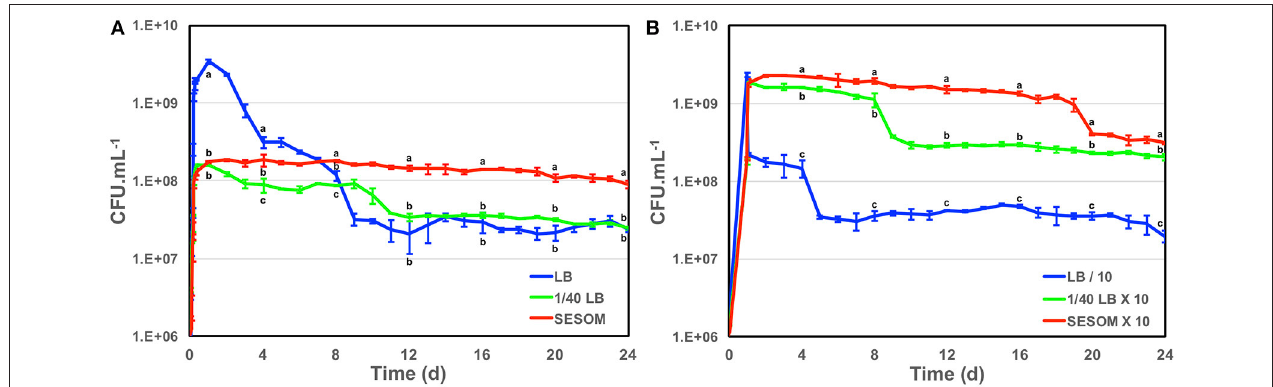
FIGURE 2 | Growth and survival of E. coli O157:H7 933D in LB, dilute LB (1/40) and SESOM (A) , and when cultures were either concentrated 10-fold in own supernatant (SESOM and 1/40th LB-grown), or diluted 10-fold (LB-grown) at 24h (B) . Error bars indicate one standard error of the mean. Different letters at the same time point indicate significant difference as determined by ANOVA test with multiple LSD comparisons.